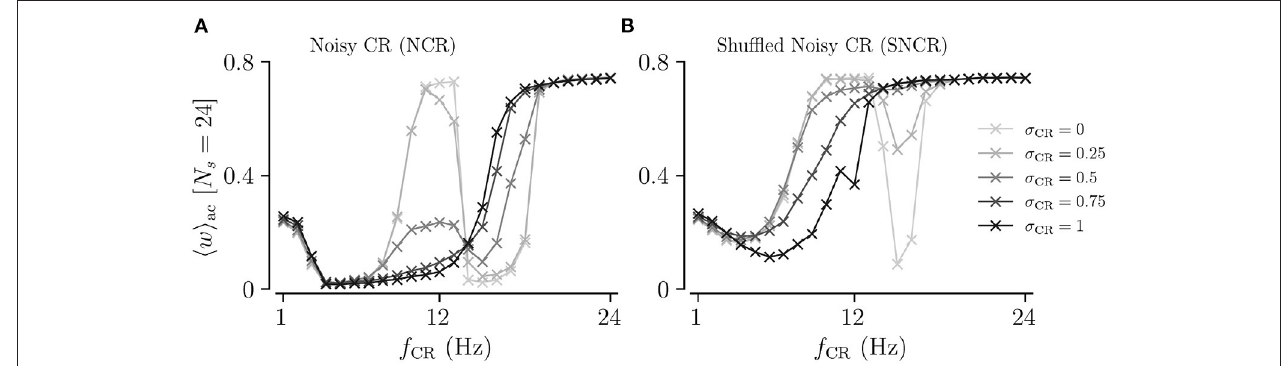
FIGURE 5 | Acute mean synaptic weight for five values of the stimulus jitter, σ CR , as a function of the stimulation frequency for N s = 24. (A,B) show results for Noisy CR (NCR) and Shuffled Noisy CR (SNCR), respectively. These graphs represent horizontal lines at N s = 24 in Figures 3 , 4 , respectively. Parameters are the same as in Figures 3 , 4